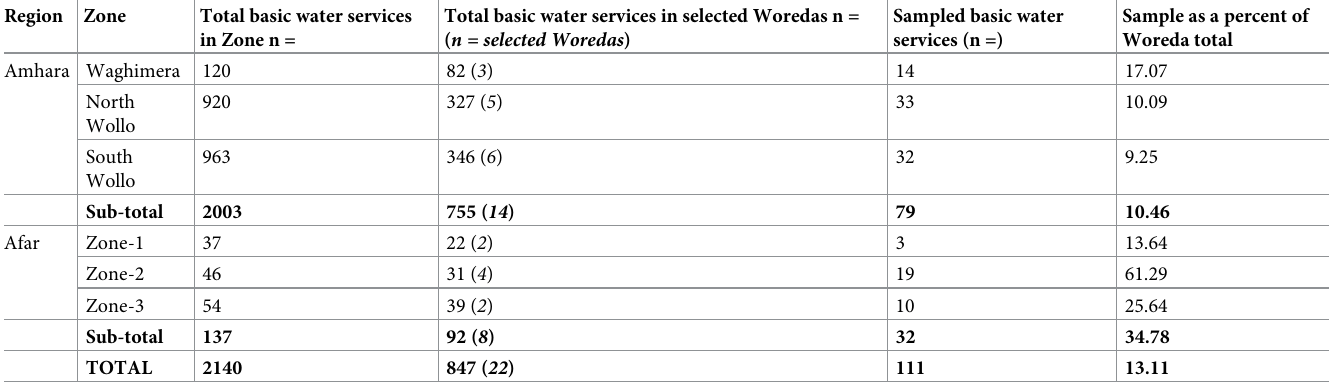
Table 2. Summary of sample in comparison to total basic water services population in study area. Region